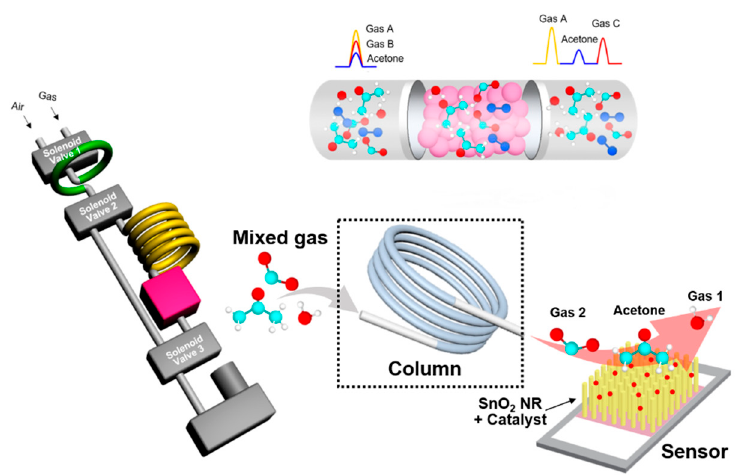
Figure 1. Schematic representation and real image of the breath acetone analyzer.